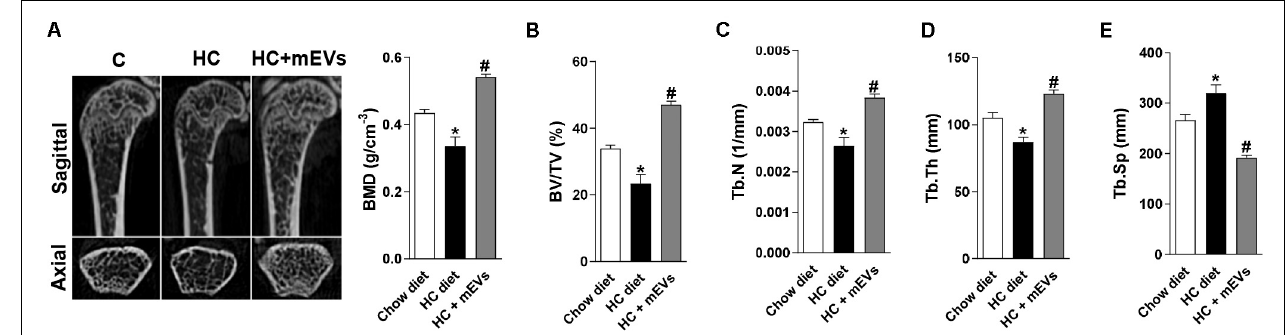
FIGURE 1 | Micro-computed tomography analysis of trabecular bone in the femur of mice fed with high refined carbohydrate-containing (HC) diet and treated with milk extracellular vesicles (mEVs). (A) Representative pictures of distal femur microarchitecture and bone mineral density (BMD), (B) trabecular bone volume fraction (BV/TV), (C) trabecular number (Tb.N), (D) trabecular thickness (Tb.Th), (E) trabecular separation (Tb.Sp). Analyses were performed in mice that received (i) a standard diet (Chow diet), (ii) a HC diet, or (iii) HC diet treated with mEVs (HC + mEVs). Values are means ± SEM of 6–7 animals per group. * vs. Chow diet and # vs. HC diet group, P < 0.05.